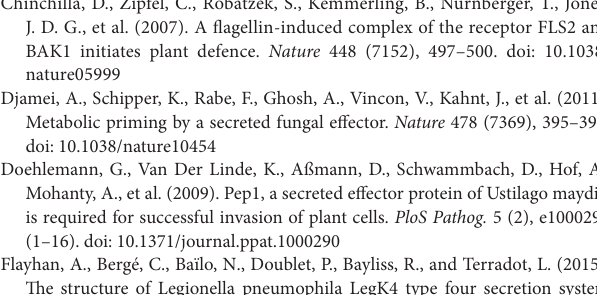
TaBlE S1 | List of putative effectors used as either bait and/or prey proteins. Gene specific primer sequences used to clone the coding sequences, signal peptide prediction scores, and peptide length are also listed. TaBlE S2 | Identity of bait proteins used in the liquid media screen. Baits were tested for autoactivity by growth in liquid culture and on plates. In the mating test (SD-Leu/-Trp/-His/-Ade) the bait strain was mated with yeast containing an empty pGADT7 plasmid. In liquid tests, strains were considered autoactive when OD600 was higher than 0.25 after 3 days of incubation at 28oC. TaBlE S3 | Primers used for sequencing of inserts (effectors) after gateway reaction. FigURE S1 | Workflow of Y2H work. Numbers represent coding sequences of putative effector proteins tested. See Supplementary Tables S1, S2, and S3 for further details. FigURE S2 | Detailed description of the subnetworks represented in Figure 2 . Core effectors were identified in Schuster et al. (2018), clusters were described in Kämper et al. (2006), iPool-Seq data was obtained from Uhse et al. (2018), and sequencing data was taken from Lanver et al. (2018). The centers of the networks are highlighted in bold; circles represent homodimers and squares represent heterodimers. FigURE S3 | Co-immunoprecipitation of 12 proteins from the UMAG_00628 subnetwork. Proteins were tagged with either 3x myc or 3x HA N-terminal tags, which was the same side of the activation and binding domains in the Y2H screen. Nicotiana benthamiana plants were transiently transformed and expressed the fusion proteins for 3 days before harvest. On the left, the interactions found by Y2H in the subnetwork subset are illustrated. Full blue boxes with white numbers represent expected interactions, empty boxes with black numbers represent protein pairs that are not expected to interact, and circles represent homodimers. On the right are the same interactions tested by Co-immunoprecipitation. The sample numbers from the Y2H matrix for each interaction pair are represented on top of the western